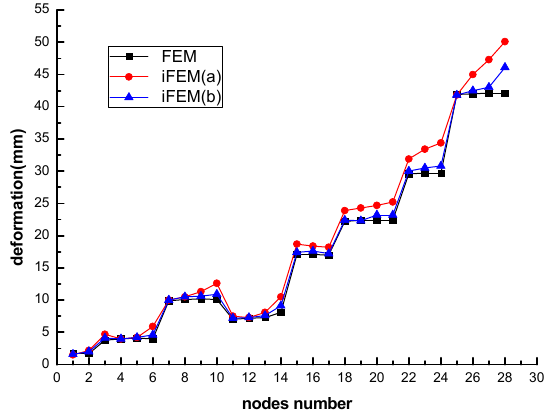
Table 1. Results of nodes deformation.